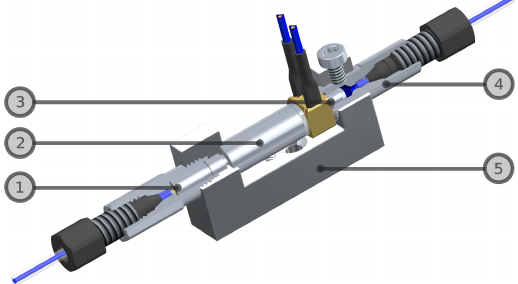
Figure 3. Mounting hardware for the SMLD 300G microvalve. (1) microvalve, (2) valve coil, (3) O-ring (material: Viton), (4) inlet adapter, and (5) valve holder. Fritz Gyger AG